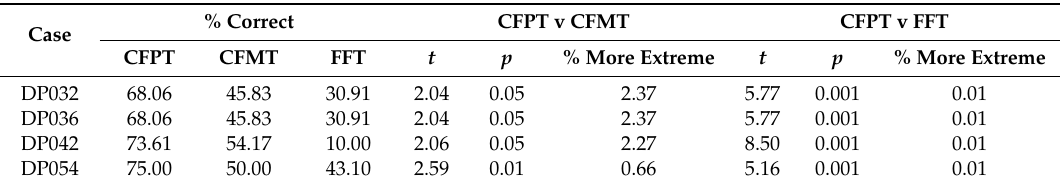
Table 6. SDT results for cases with significant dissociations between intact CFPT performance and impaired CFMT and famous face test (FFT) scores. The sequential Bonferroni correction is applied to correct for multiple